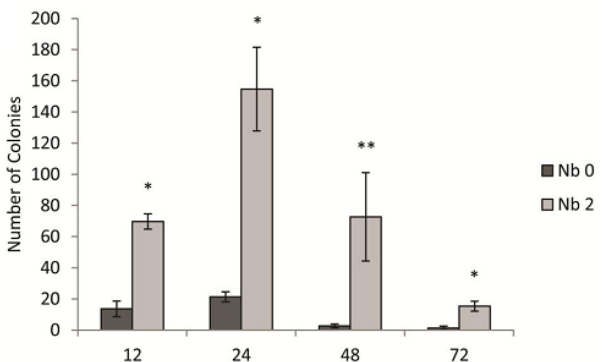
Figure 4. Time course of transduction assays in the presence or absence of 2 µg/mL novobiocin (Nb). Transduction assay of strains ∆RC6 and ∆LHII with time points at 12, 24, 48 and 72 h, yielding 5.1-, 7.3-, 27.3-, and 11.5-fold average increases in gene transfer, respectively, compared to cultures grown without Nb at the same time point. Error bars give standard deviations (n = 3), and * p < 0.05, ** p < 0.1 relative to the control cultures grown without Nb at each time point.